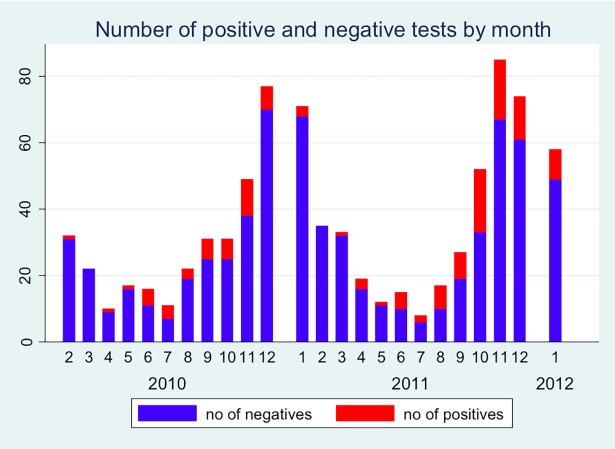
Number of positive and negative M. pneumoniae tests by year and month.